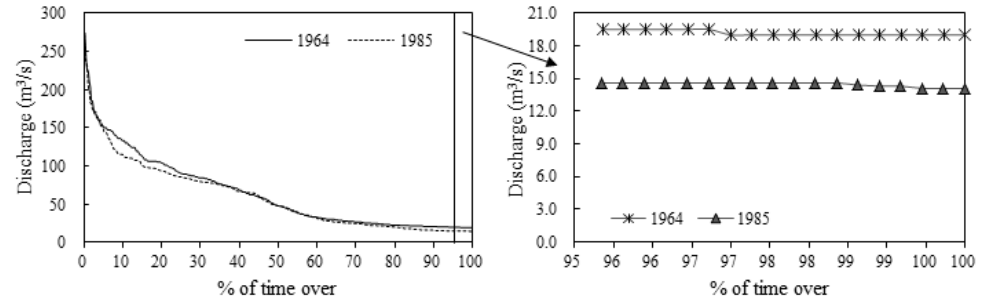
Figure 5. An example of flow duration curve for pair 1964 vs. 1985 in Phase 1 and Phase 3 (flow duration curves for other selected pairs in the low level of forest harvesting n period can be found in Figure A2).